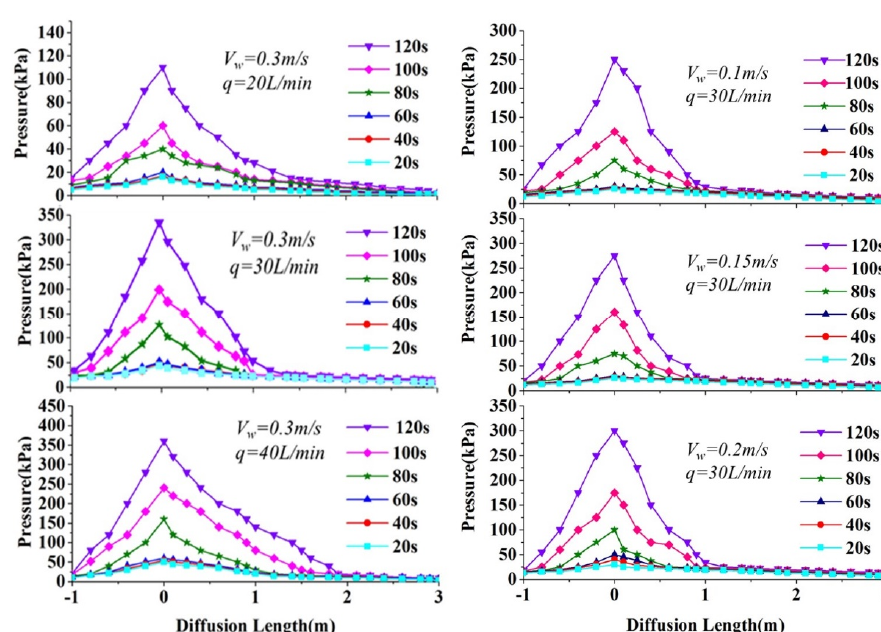
Figure 9. Variation of fluid pressure in the fracture replica during grouting.